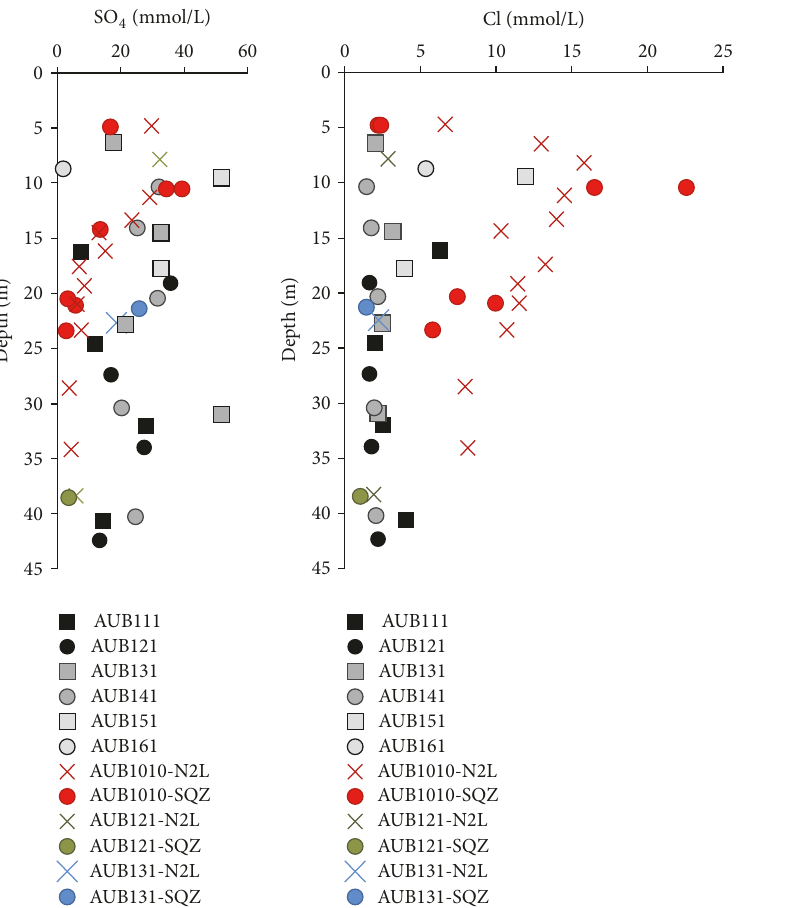
Figure 8: Chloride and sulfate concentrations of the AUB1010 borehole as a function of depth based on anion leaching data and directly measured on pore waters extracted by squeezing. Different symbols are used for data obtained on different boreholes. N2L indicates data obtained by leaching on samples preserved in liquid nitrogen, SQZ indicates data obtained on pore waters extracted by SQZ, the others correspond to data obtained by leaching on samples conditioned in aluminum